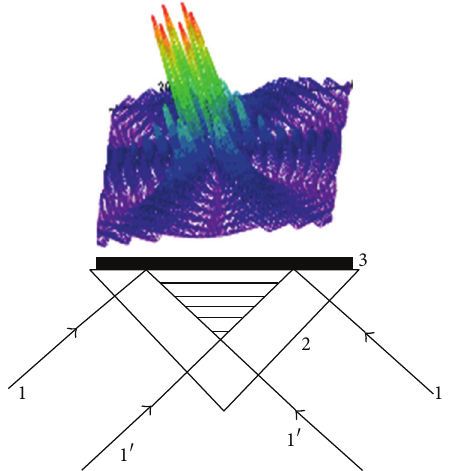
Figure 11: Schematic set-up for excitation of Bessel surface multi- plasmon polariton. 1 and 1 󸀠 are extreme rays of conical beams excited Bessel surface plasmon polaritons, and 2 is conical lens on the basic surface of which metal film 3 is plotted.